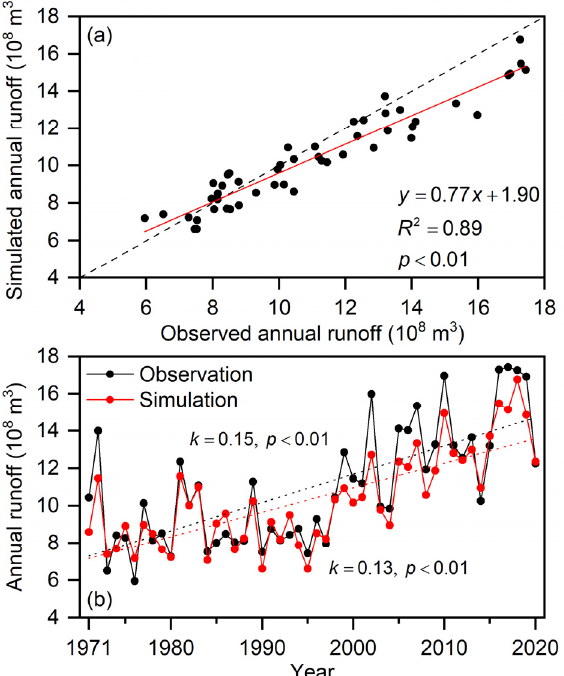
Figure 8. Comparison of the simulated and observed annual runoff from 1971 to 2020. ( a ) Simulated annual runoff versus Observed annual runoff; ( b ) Interannual variation of observed runoff and simulated runoff.